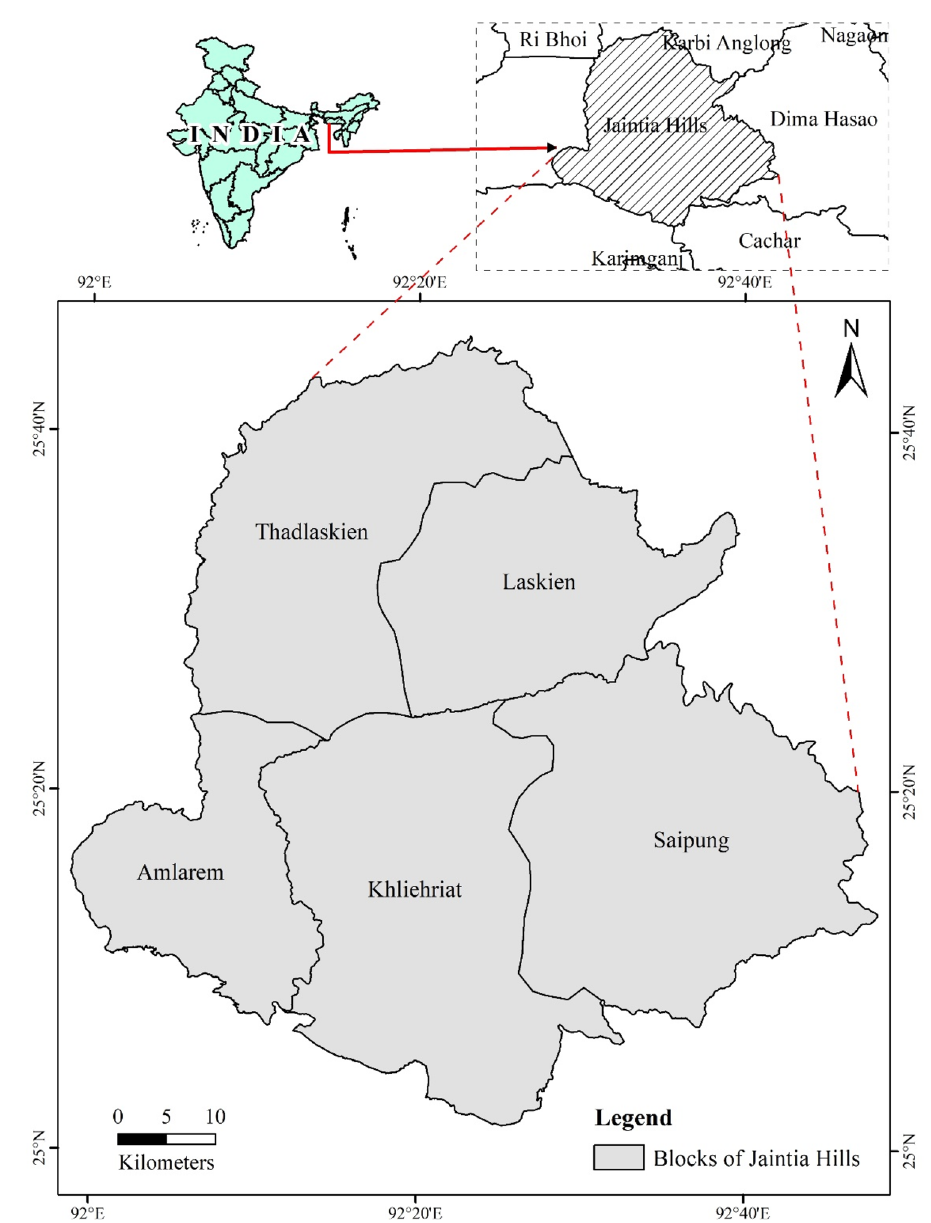
Fig. 1 Study area map: Jaiñtia Hills, Meghalaya